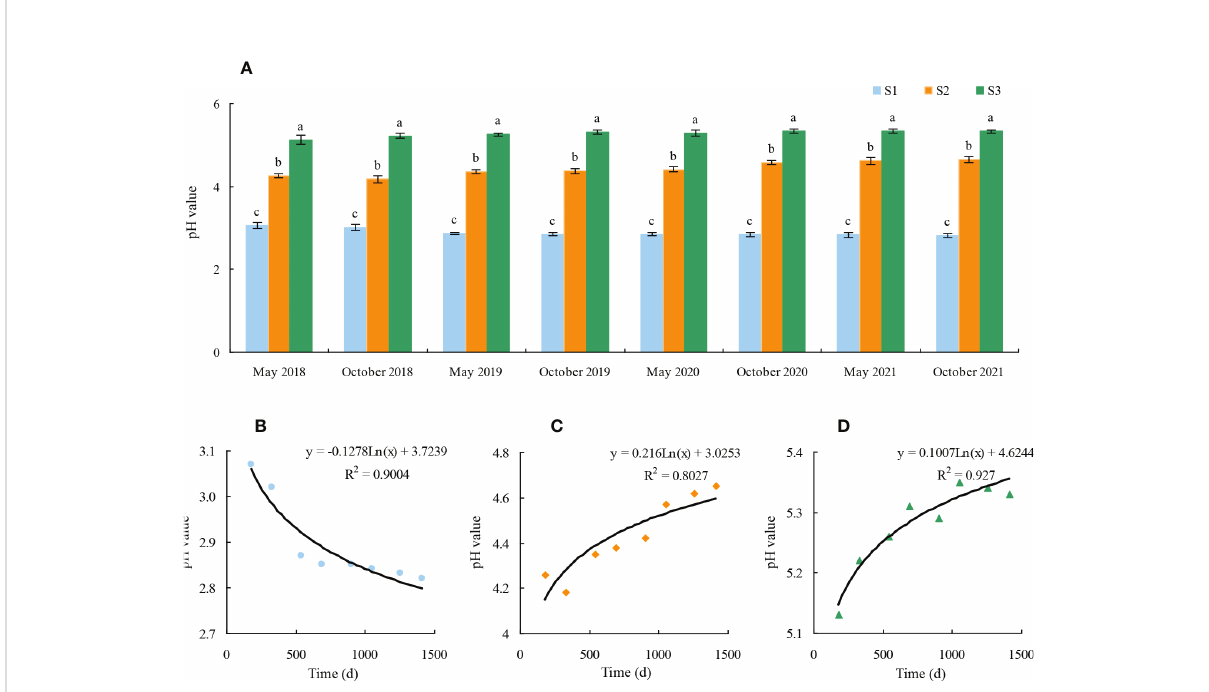
FIGURE 2 Effect of different fertilization treatments on soil pH in tea plantation S1: 100% Chemical fertilizer; S2:50% Organic fertilizer +50% chemical fertilizer; S3: 100% Organic fertilizer; (A) Effect of 4 consecutive years of fertilization on soil pH in tea plantation; (B) Trend analysis of soil pH after 4 years of continuous treatment in S1 tea plantation; (C) Trend analysis of soil pH after 4 years of continuous treatment in S2 tea plantation; (D) Trend analysis of soil acidity after 4 years of continuous treatment in S3 tea plantation; Different lowercase letters indicate the signi fi cant difference at P < 0.05 levels among different